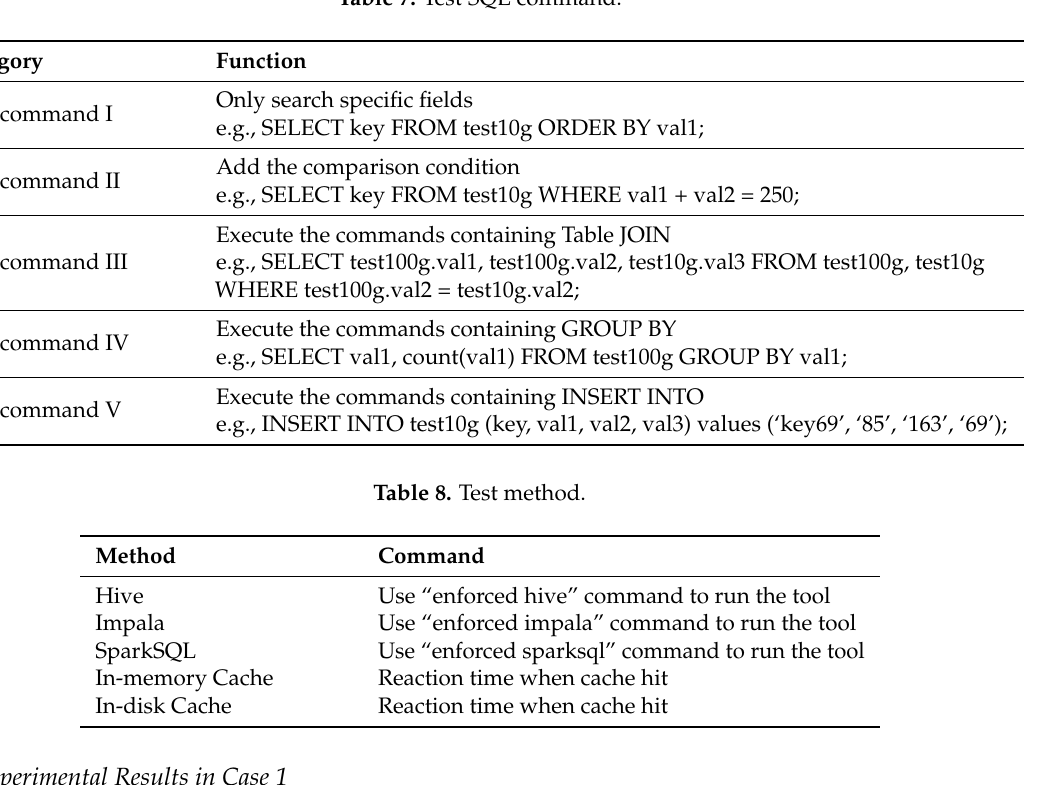
Table 7. Test SQL command.